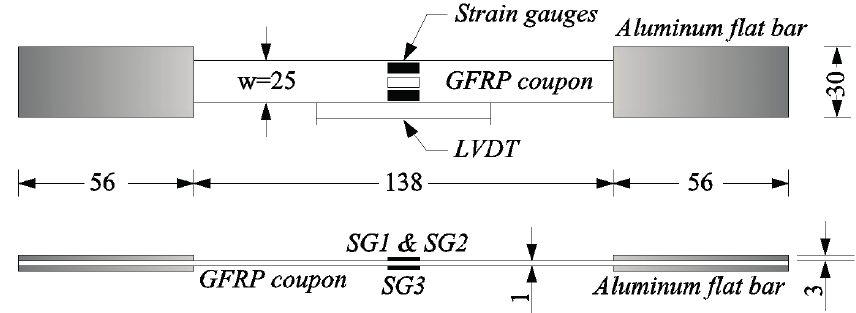
Figure 3. GFRP tension coupon details (unit: mm).